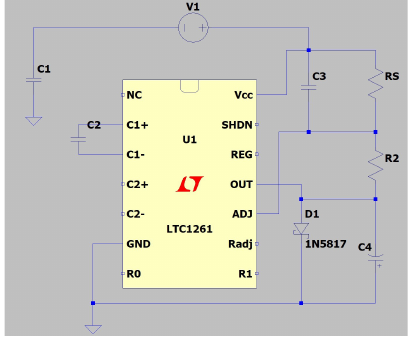
Figure 4. Schematic used for the SC